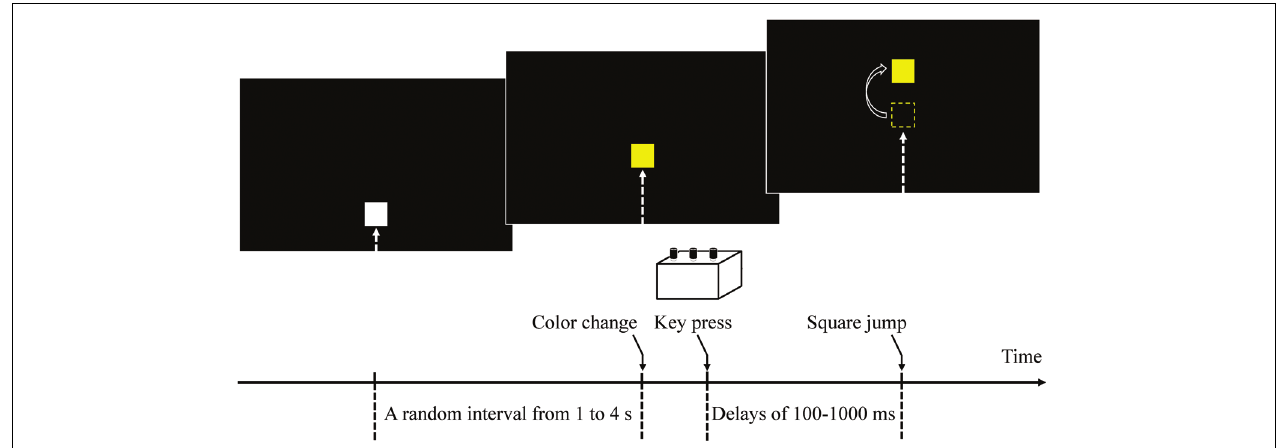
FIGURE 1 | A timeline of a trial. Each trial started with a 180 mm × 245 mm black screen, and with a 5-mm white square which appeared from the bottom of the screen and moved upward at a speed of 20 mm/s. Participants were instructed to push a specified button as quickly as possible with their dominant index finger when they saw the color of the square change to yellow. After pushing the button, the square jumped 25 mm upward at a random delay (100, 200, 300, 400, 500, 700, or 1000 ms).